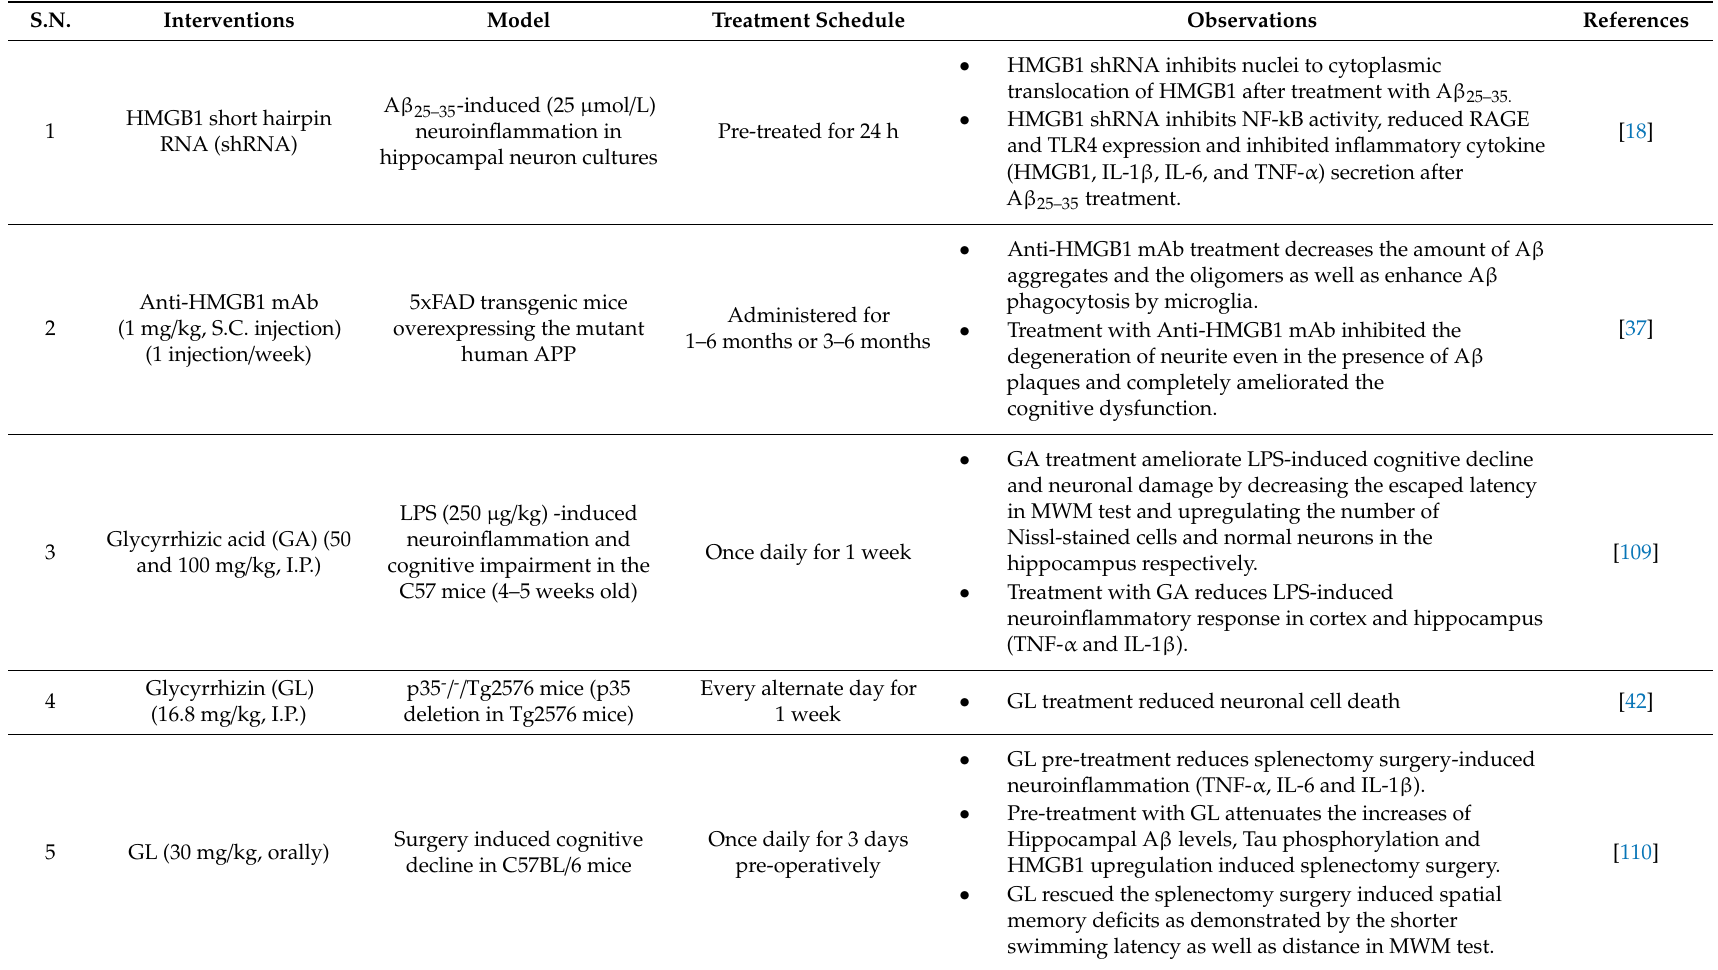
Table 1. Summaries of studies reporting HMGB1 targeted therapies in AD and related